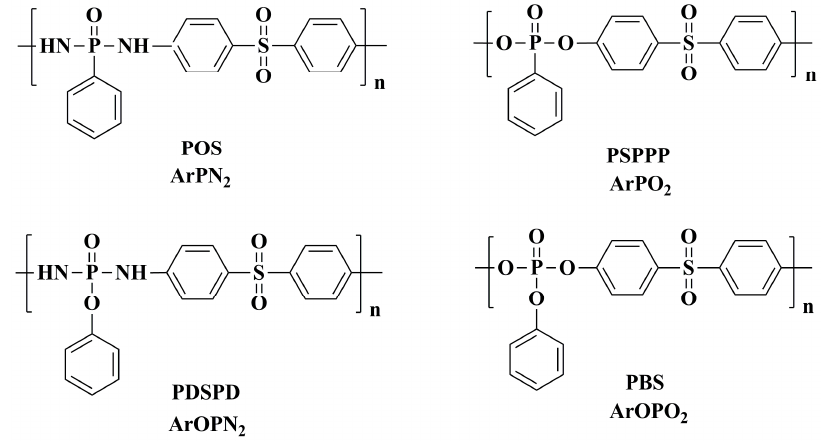
Figure 1. Chemical structures of the polysulfones used in this study.